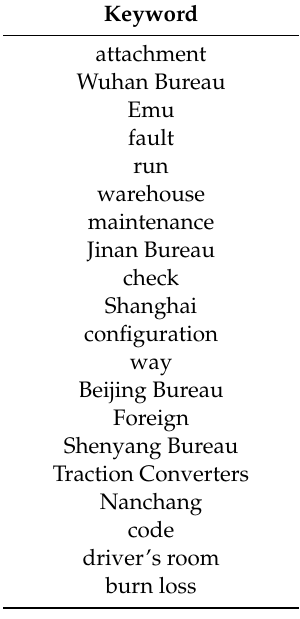
Table 1. Top 20 keywords in NWS methods (translated to English).